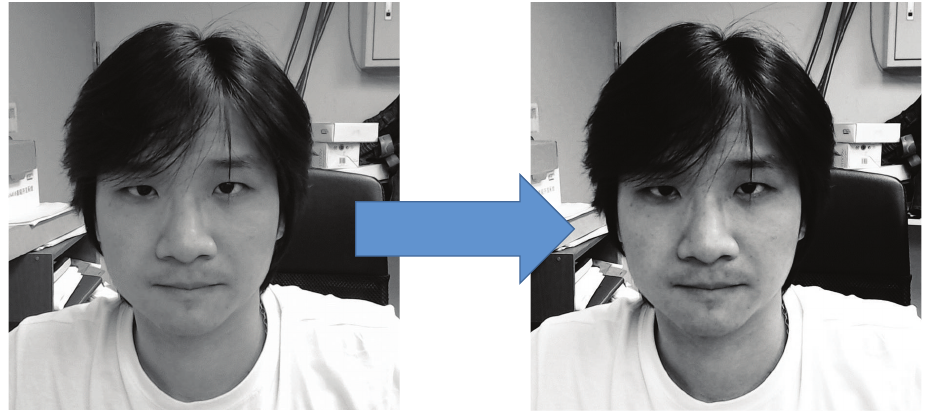
Figure 4: The histogram equalized facial images.